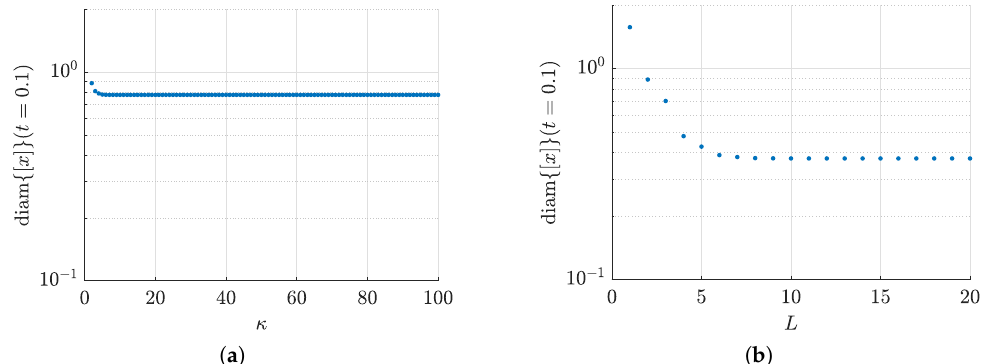
Figure 2. Dependence of the solutions according to Theorems 4 and 5 on the iteration numbers and series expansion orders in example (37) with (38) and ν = 0.5: ( a ) Multi time step Picard iteration; ( b ) Temporal series expansion.